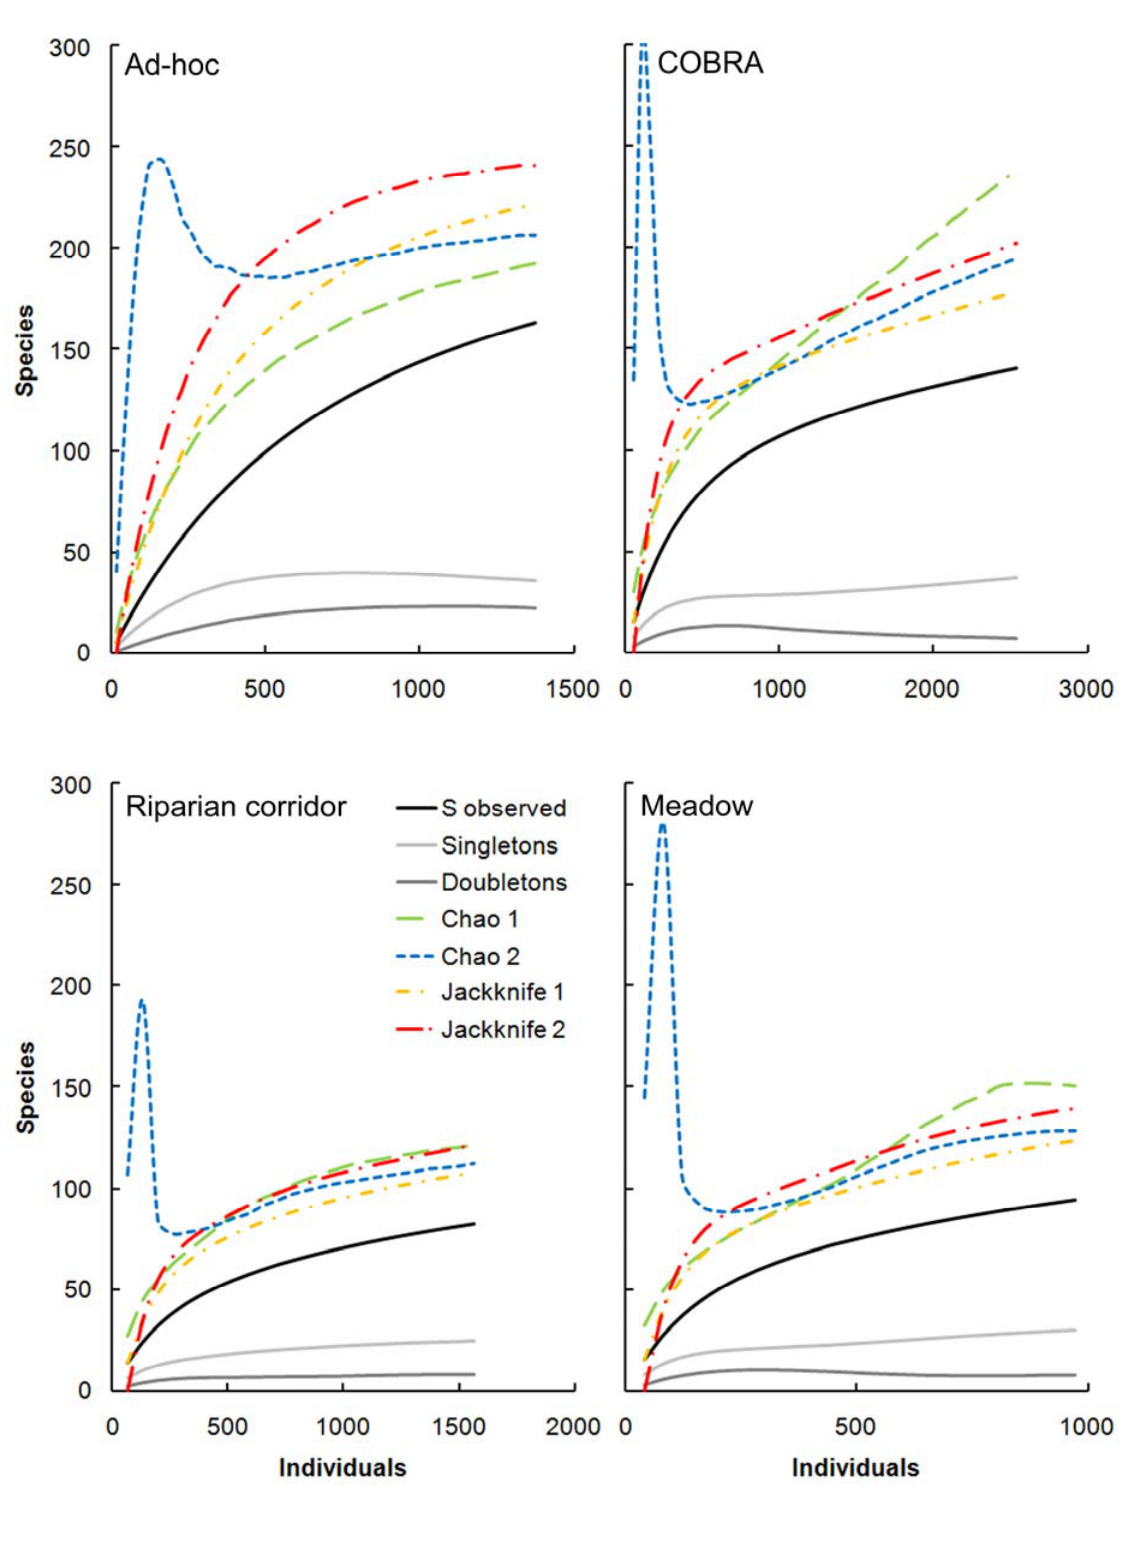
Figure 3. Randomized accumulation curves for observed species richness, singletons, doubletons, and several different non-parametric species richness